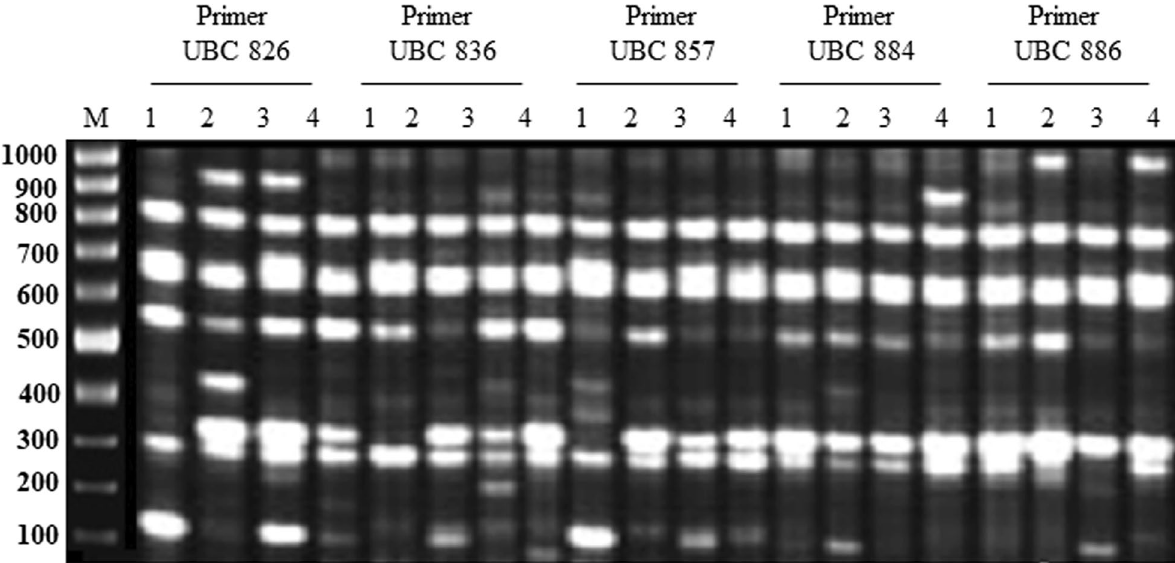
Fig. 7 ISSR profile of Allium cepa treated with (1) tap water as control, (2) 25%, (3) 50% and (4) 100% of mixed wastewater at 12th day after germination, using 5 different primers M